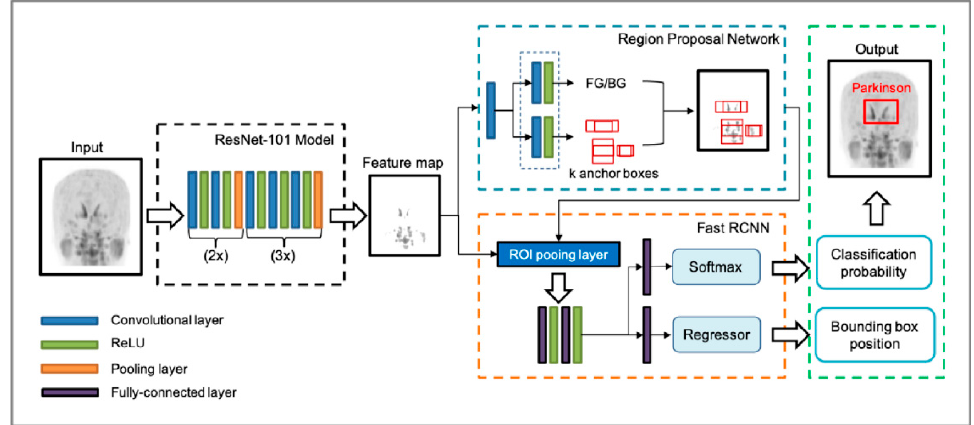
Figure 3. The architecture of the faster region-based convolutional neural network (Faster R-CNN) used. The Faster R-CNN consists of the region-proposal network (RPN) and the fast R-CNN. From the input image, a ResNet-101 model without fully connected layers was utilized to extract a feature map. RPN learns to determine whether an object is present in the input image by placing a set of anchors. As the network propagates each pixel in the feature map, these anchors are checked to determine the objectness score and refine the anchor’s coordinates of rectangles in the region of interest (ROI). The output features from the ROI pooling layer are fed into the fully connected layers with the softmax and regressor branches, finally generating classification probability and bounding box position. ReLU, rectified linear unit.